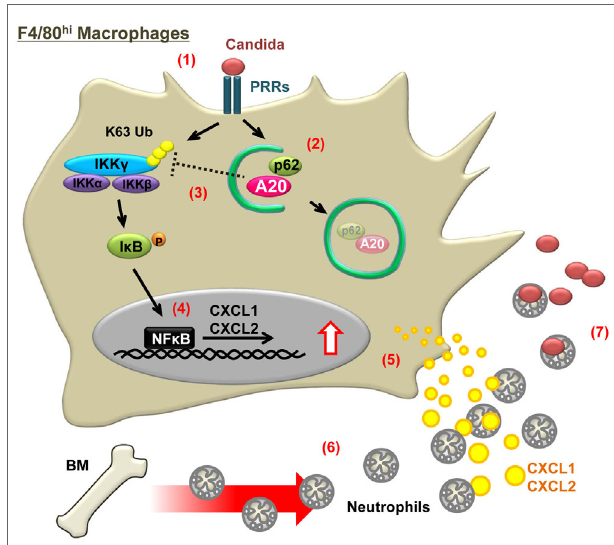
FiGURe 1 | Schematic illustration of a mechanism in which autophagy enhances antifungal immune responses by sequestering A20 . Numbers in the figure indicate steps from fungal detection to killing by hosts and correspond to the following events: (1) detection of C. albicans by PRRs, such as dectin-1 and TLR2, expressed on F4/80 hi tissue-resident macrophages; (2) autophagy induction and sequestration of A20 in autophagosomes, and A20 delivery to autophagosomes by p62; (3) IKK γ ubiquitination by sequestering A20; (4) enhancement of NF κ B activity; (5) increased chemokine production; (6) recruitment of neutrophils to infected sites (i.e., where the responding tissue-resident macrophages are located); and (7) Killing of fungi by